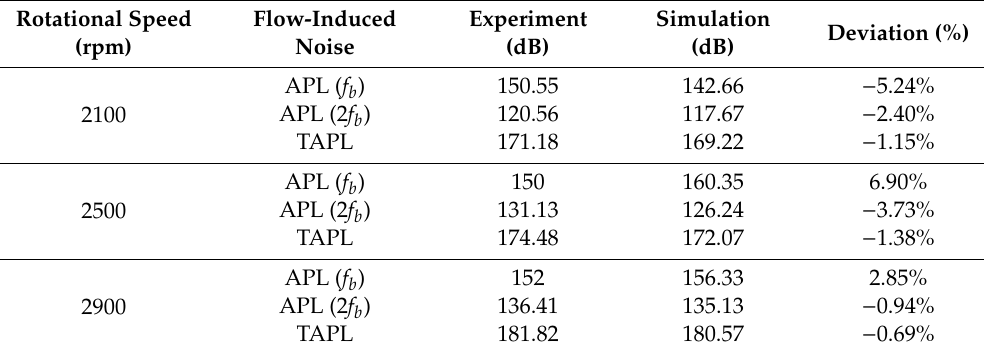
Table 4. The deviation of flow-induced noise obtained by experiment and simulation.